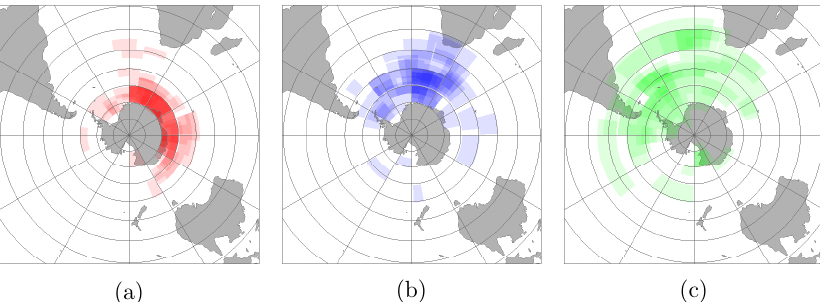
Figure 12. Estimated source regions of the modelled and measured precipitation events for the available trajectories arriving at (a) 600hPa, (b) 500hPa, and (c) 300hPa. The stronger the colour, the more frequently the respective source area was found.